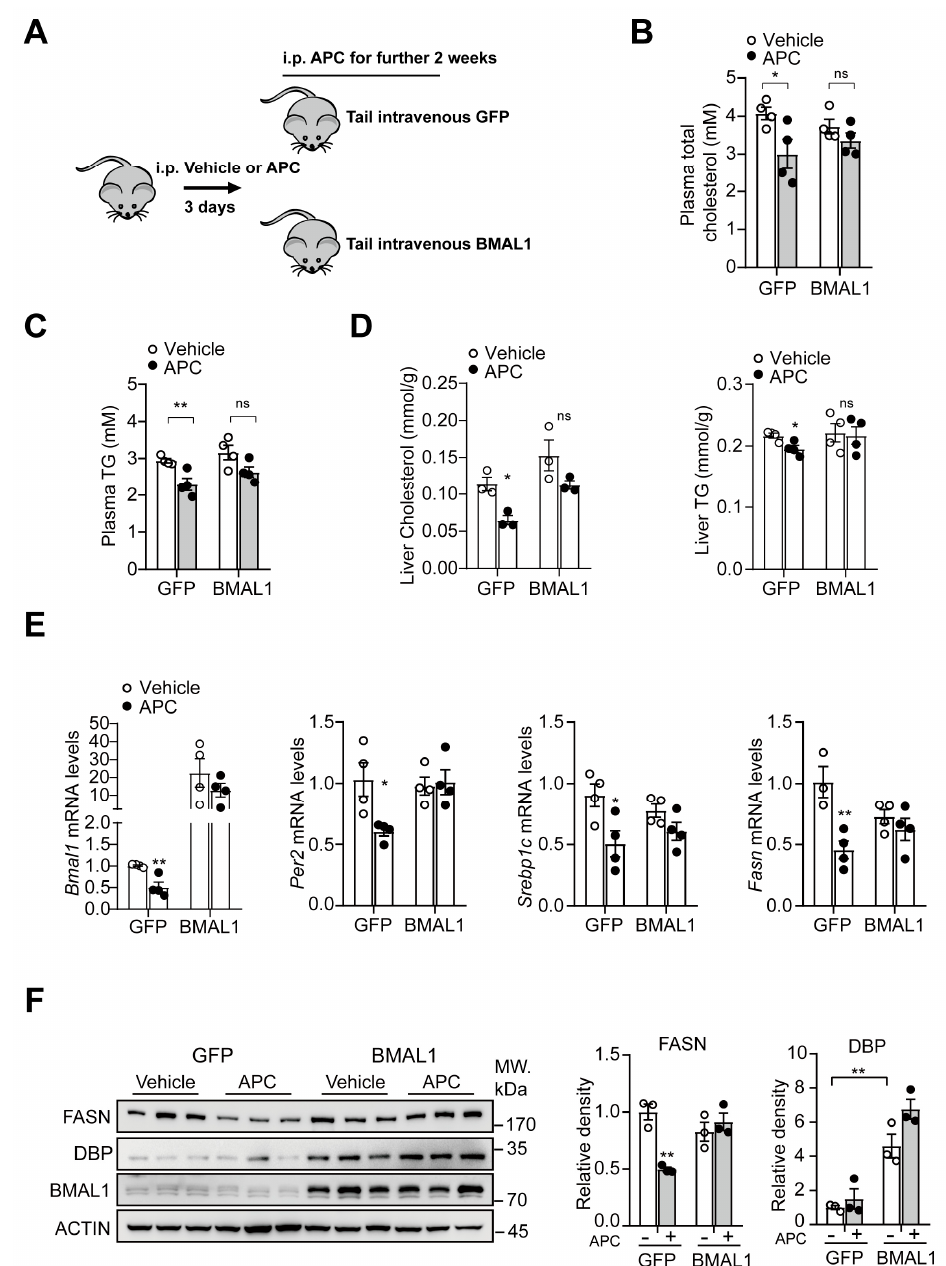
Figure 7. In db/db mice, APC inhibits lipid synthesis in a BMAL1 − dependent manner at ZT20: ( A ) schematic description of animal experiments. The mice were treated with vehicle or APC (20 mg/kg) at ZT17. The experiments and sample collection were performed at ZT20; ( B , C ) the contents of plasma total cholesterol and plasma triglyceride (TG) in the db/db mice. The mice were treated the same way as ( A ) ( n = 3 − 4 per group); ( D ) the levels of liver TG and TC in the db/db mice ( n = 3 − 4 per group); ( E ) mRNA levels of Bmal1 , Per2 , Srebp1c , and Fasn analyzed by real − time qPCR in the animal livers ( n of animal = 3 − 4 per group); ( F ) Western blots of BMAL1, DBP, and FASN proteins in the animal livers (n of animals = 3 per group). * p < 0.05; ** p < 0.01.